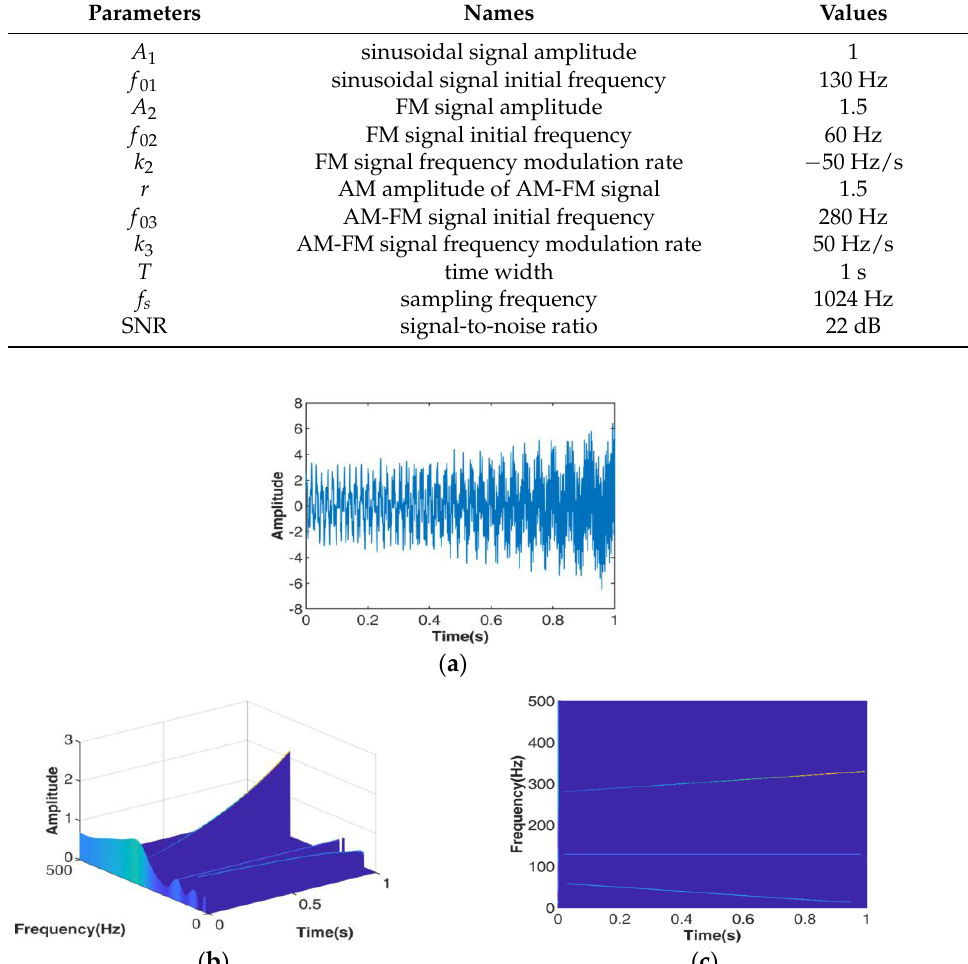
Figure 5. Time-frequency analysis of rotor vibration fault signal in SEST . ( a ) Signal time domain representation; ( b ) SEST three-dimensional representation; ( c ) SEST time-frequency representation.